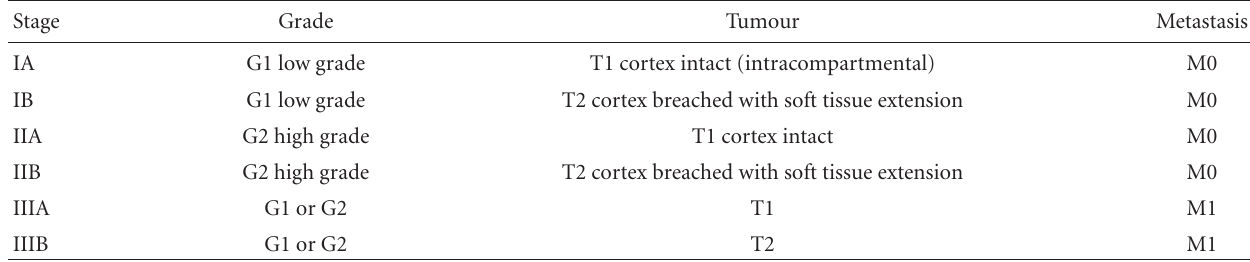
Table 2: Enneking staging.